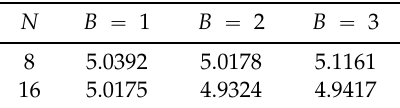
Table 9. Average Results on the 1997 AVIRIS Images (PAQ8).